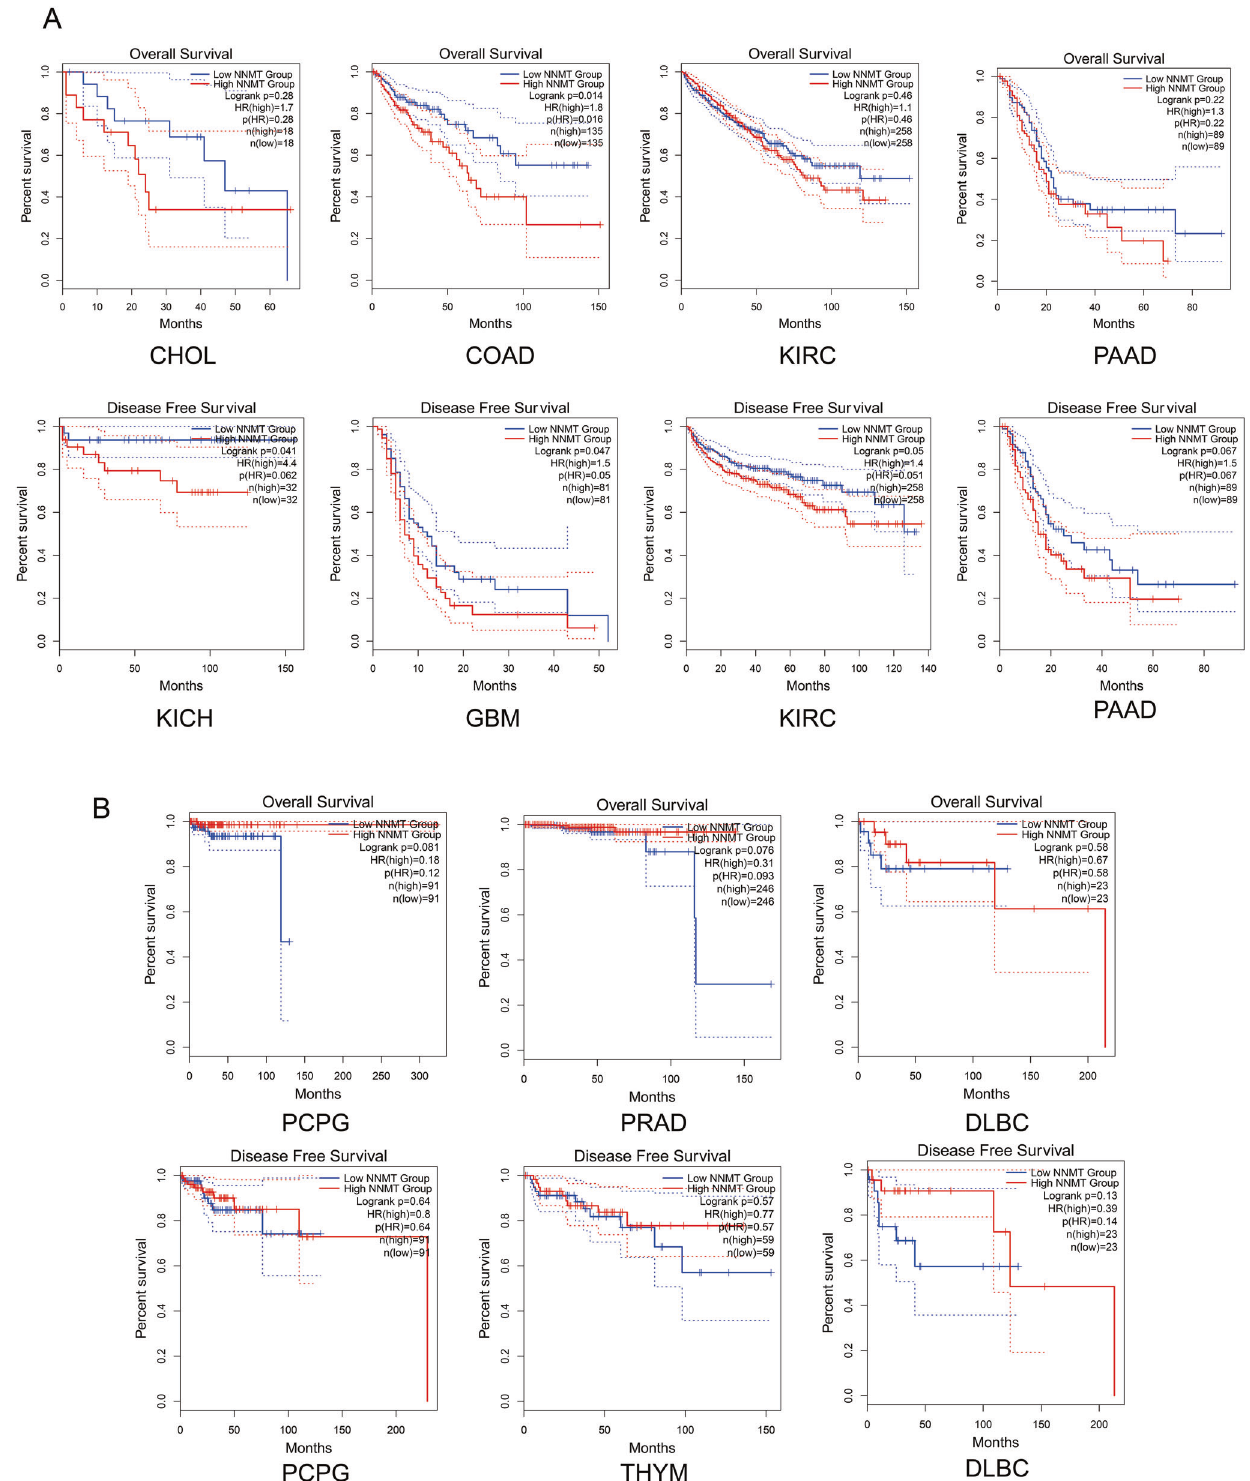
Fig. 5 Correlation analysis of NNMT expression with OS and DFS in different cancer patients. Data were processed by GEPIA2 (http:// gepia2.cancer-pku.cn/#index), a web server for cancer and normal gene expression pro fi ling and interactive analyses. A , B Kaplan – Meier survival plots for certain tumor